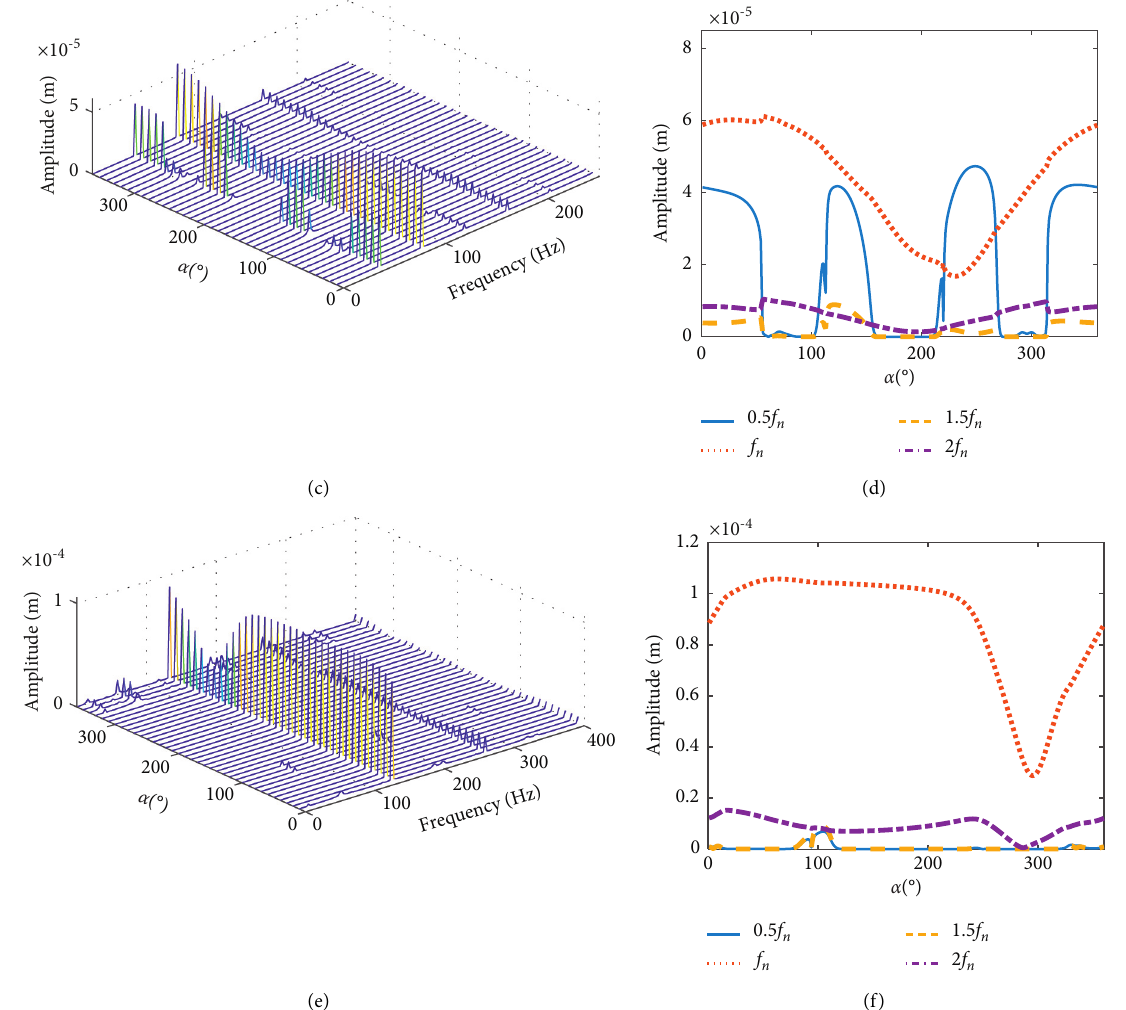
Figure 12: Waterfall diagram of bearing vibration spectrum and diagram of spectrum amplitude varying with α : (a) waterfall diagram, 2000rpm; (b) waterfall diagram, 5000rpm; (c) waterfall diagram, 8000rpm; (d) spectrum amplitude, 2000rpm; (e) spectrum amplitude, 5000rpm; (f) spectrum amplitude,